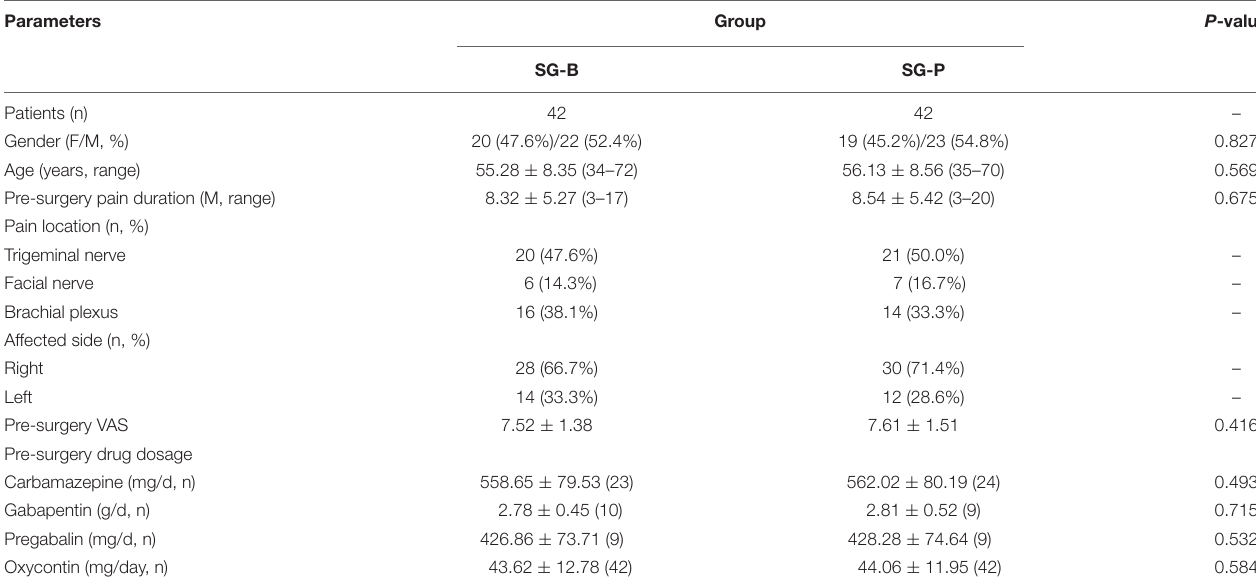
TABLE 1 | Pre-surgery patient characteristics in SG-B and SG-P groups.